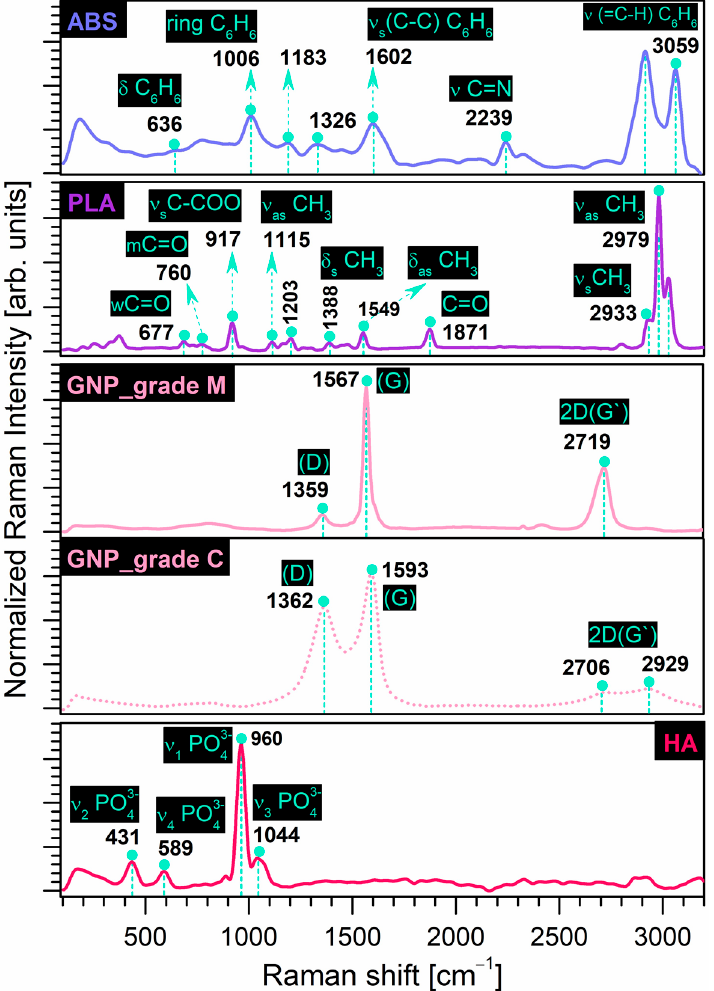
Figure 2. Comparative Raman spectra of prime (ABS, PLA) and reinforcement (GNP, HA) precursor materials. Table 2. Raman shifts assignment for prime and reinforcement precursor